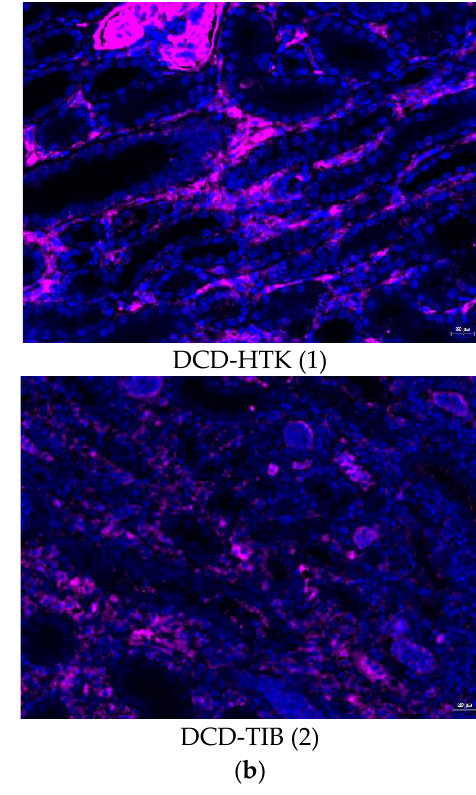
Figure 6. ( a ) Histological Evaluation with Multiplex antibody staining for CD31, NGAL, Caspase 3, ZO-1, and Syndecan-1 positive cells. Mann – Whitney test p adjusted= 0.0012 ( b ) Appearance of syndecan-1 positive cells (pink fluorescence) with DAPI nuclear staining in the DCD HTK (1) and HTK TIB group (2). Magnification 200×, Scale bars 20 µm. Images are created with TissueFAXS Viewer 7.1.120.